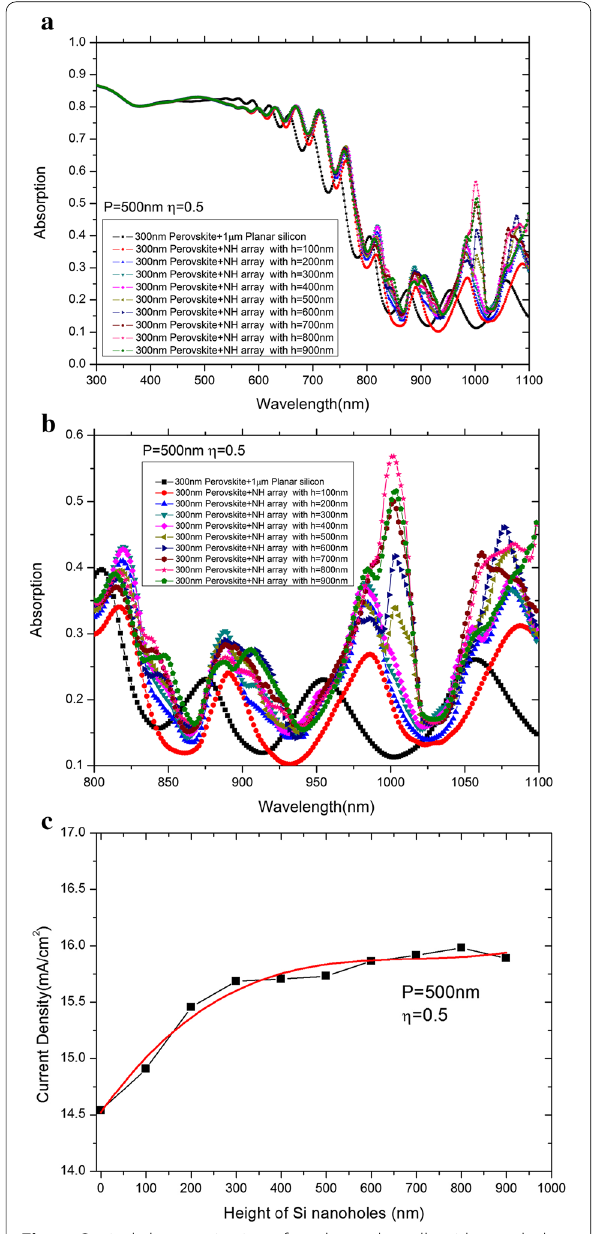
Fig. 4 Optical characterization of tandem solar cells with nanoholes array. a Absorption spectra versus height at fixed P η 0.5. b The magnified view of the absorption spectra ranges from = 800 to 1100 nm. c Current density versus height at fixed P and η =